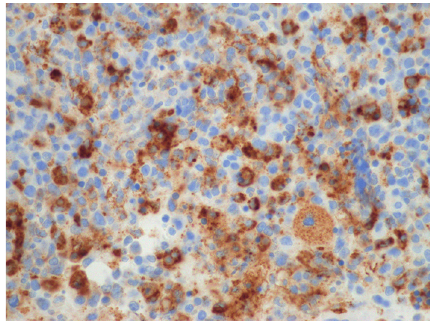
Figure 2: Bone marrow biopsy, CD68 immunohistochemistry stain, increased histiocytes, and